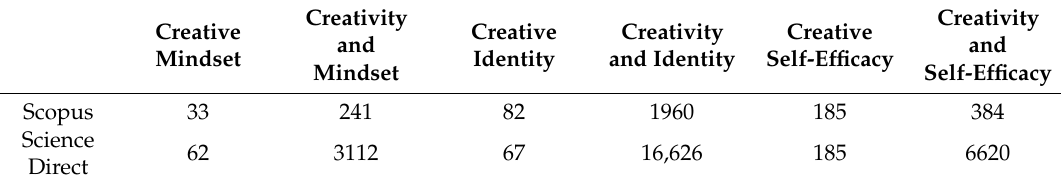
Table 1. Numbers for specific theory